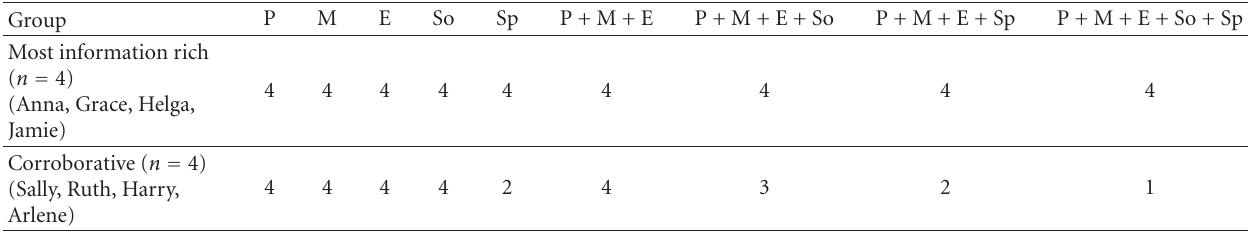
Table 2: Corroborative analysis: number of interviewees in each group who referenced specific dimensions ∗ and specific combinations of